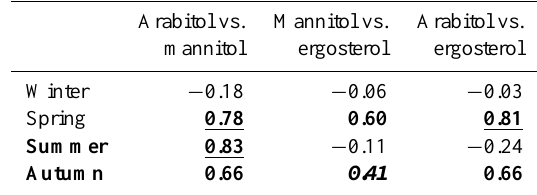
Table 2. Pearson coefficient ( r) was used in order to determine the correlation between the markers during each season. Arabitol and mannitol are highly correlated during the year apart from the winter season. Ergosterol shows moderate correlation with both arabitol and mannitol during spring and autumn.